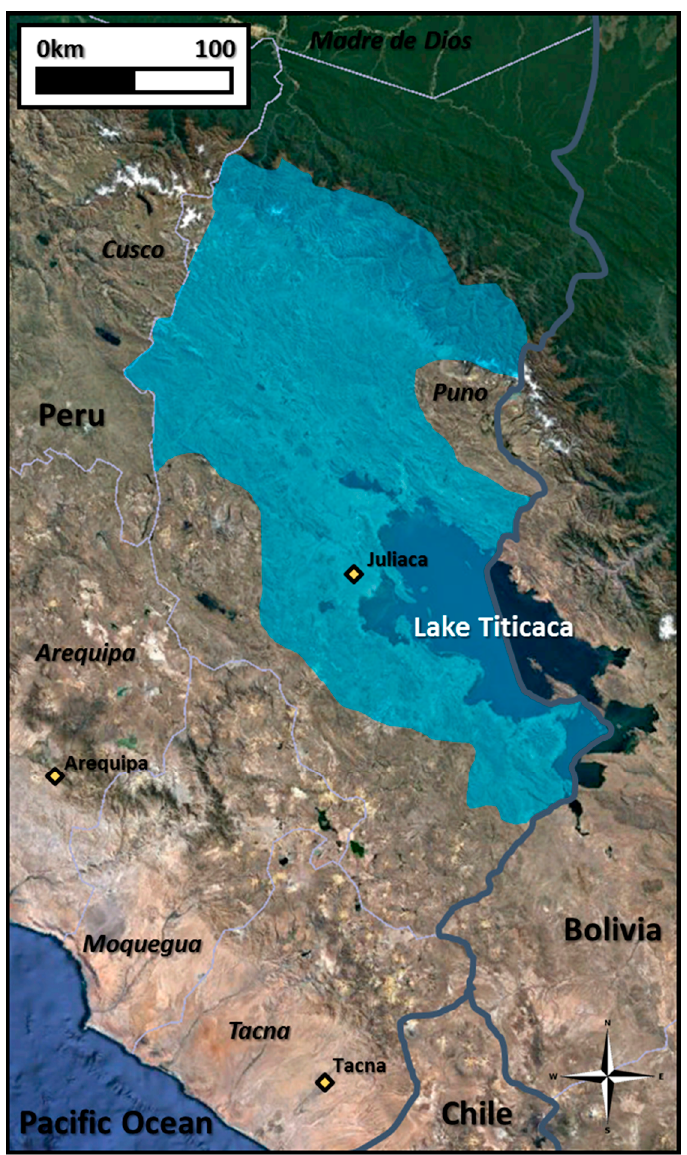
Figure 1. Map of southern Peru, with the case-study sub-department highlighted in blue. Three major regional urban centers are identified for spatial context.